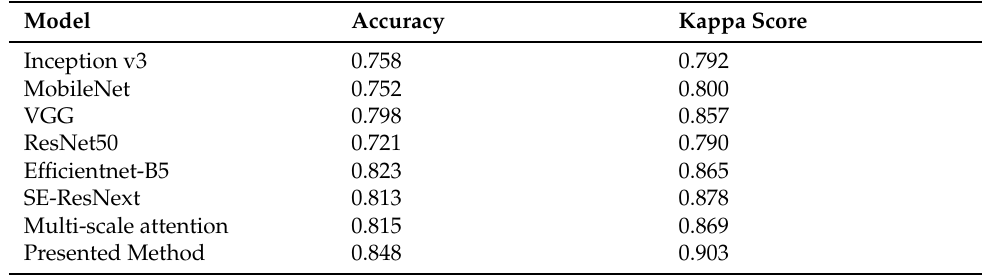
Table 7. Quantitative